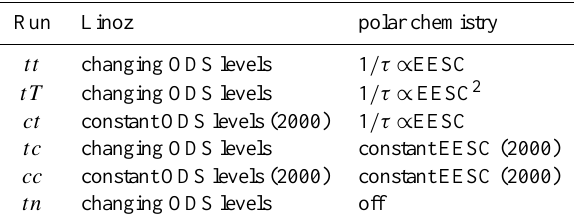
gas phase chemistry (Linoz) mode and polar chemistry (polarchem) mode used. For details see